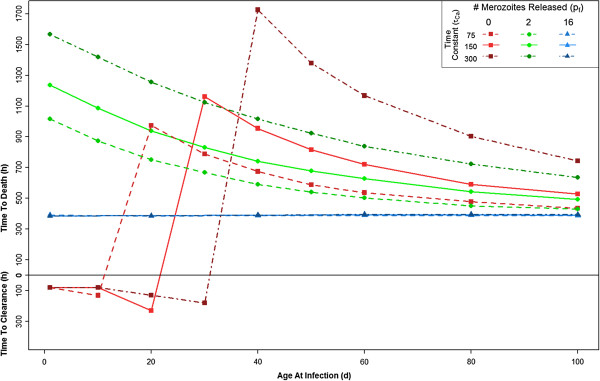
The effect of different rates of HbF:HbA production. Three distinct sets of parameters were used: τCf =50 and τCa =75; τCf =100 and τCa =150; or τCf =200 and τCa =300. As expected, when τCf and τCa are larger (i.e. there is more HbF for longer), the host is protected for a longer period of time. The solid lines are repeated from Figure 2 for comparison.